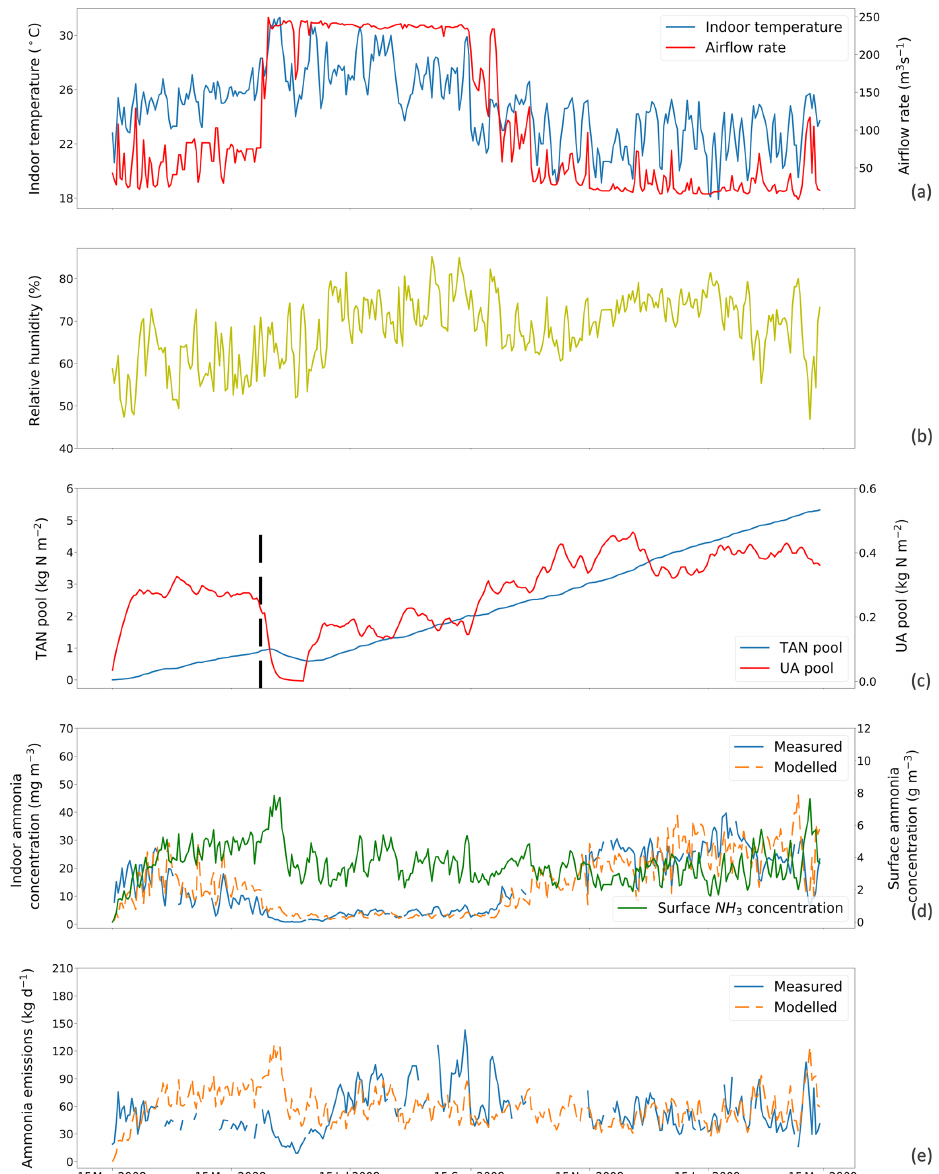
Figure 5. The same as Fig. 4 but for simulations using a fixed resistance ( R ∗ ) value of 14369sm − 1 for House B at site NC2B, Nash, North Carolina, from 15 March 2008 to 15 March 2009. The black dashed line indicates the house-emptying date of 3 June